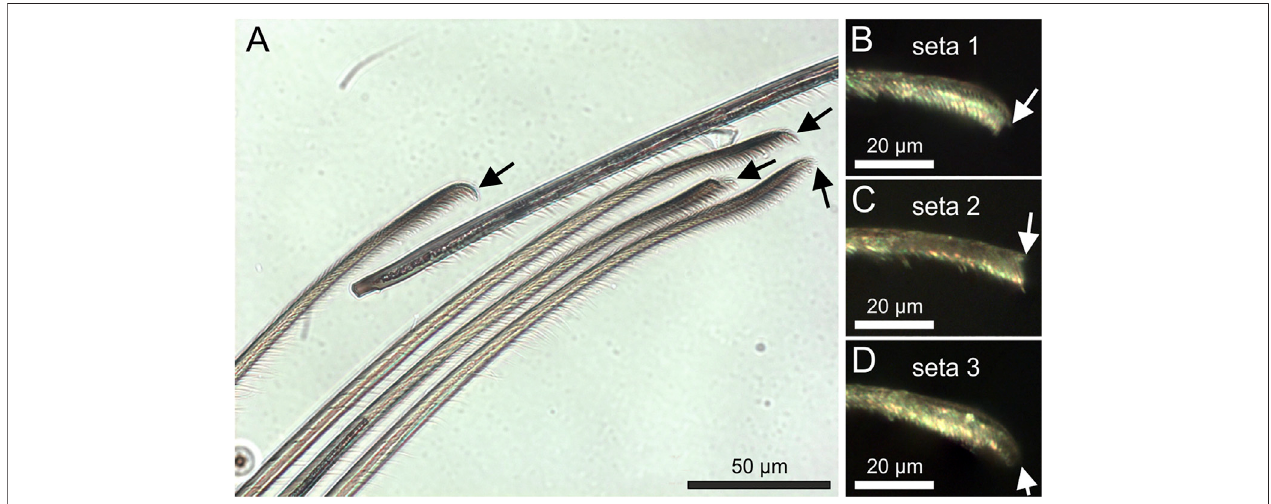
FIGURE 8 | (A) Transmitted light microscopic side view of a bunch of neighboring attachment setae plucked from the center of the pretarsal scopula. Different tip shapes (arrows) are clearly visible (B – D) Re fl ected light microscopic images of the tips of the setae used for the adhesion measurements in the experimental setup. The arrows point to the tips of the seta backbone.